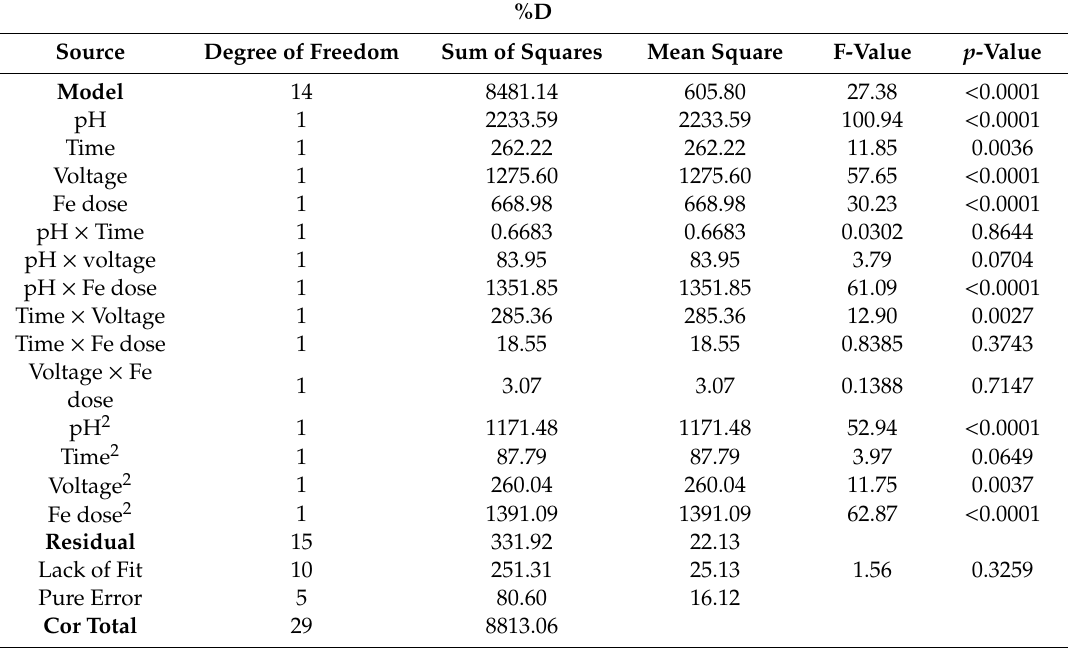
Table 3. The statistical analysis in terms of ANOVA and the impact of PEF operational parameters over the response